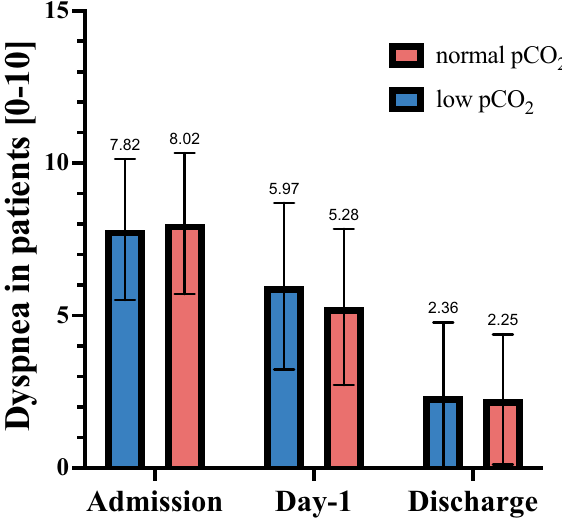
Figure 2. Comparison of dyspnea perception between patient with different pCO 2 level. Assessment of dyspnea perception was performed with the use of a self-reported 10-point Likert scale. Red—patients with normal